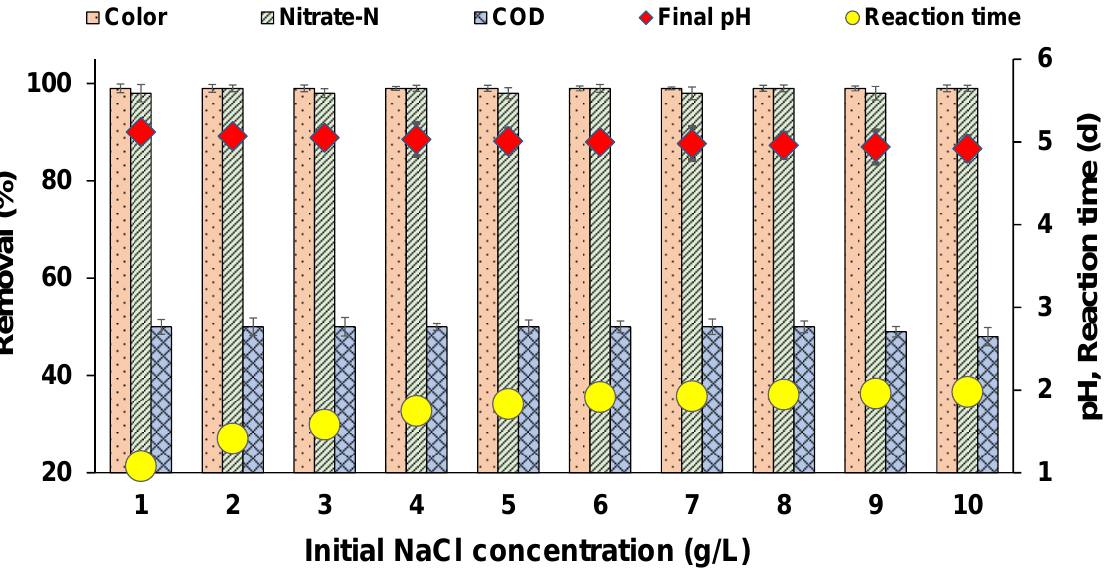
Figure 10. Effect of salinity on MO decolourization (temperature: 30 ± 2 °C; volume: 150 mL; MLSS: 15.26 g/L; RPM: 110 ± 2; time: 96 h).